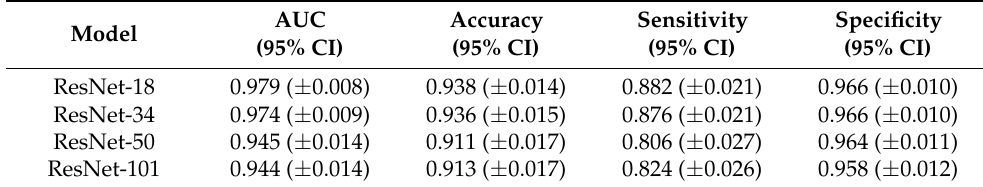
AUC, area under the curve; CI, confidence interval.